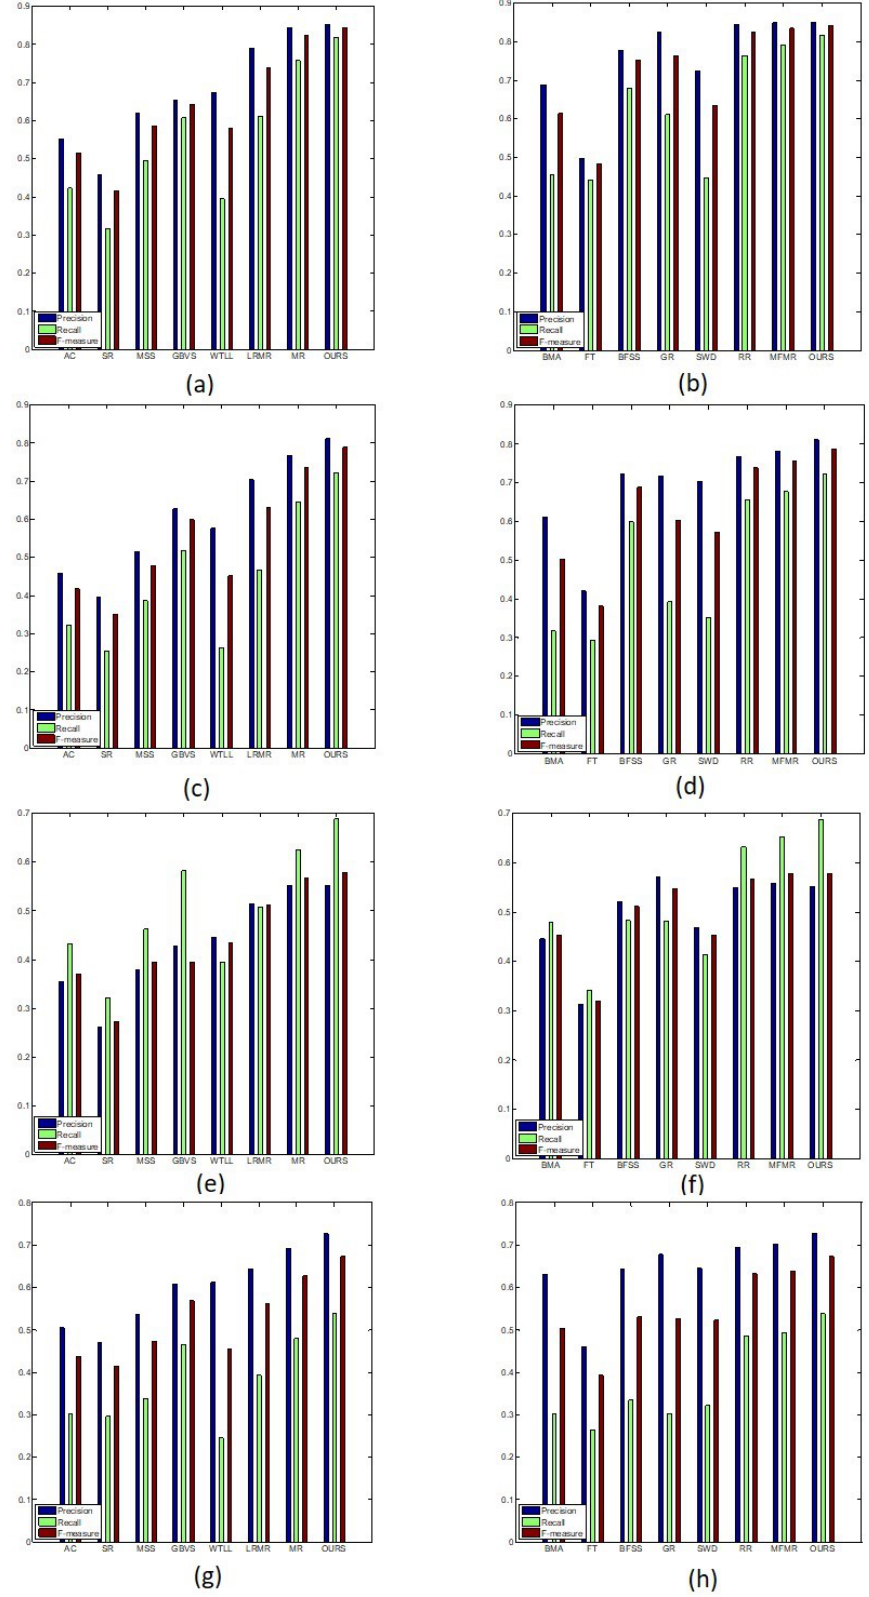
Figure 7. The average precision, recall and F-measure scores of different methods: ( a , b ) MSRA-5000 dataset; ( c , d ) ECSSD dataset; ( e , f ) DUT-OMRON dataset; ( g , h ) SOD